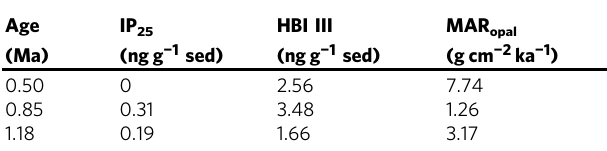
Table 1 Data points that do not fi t the sea ice state